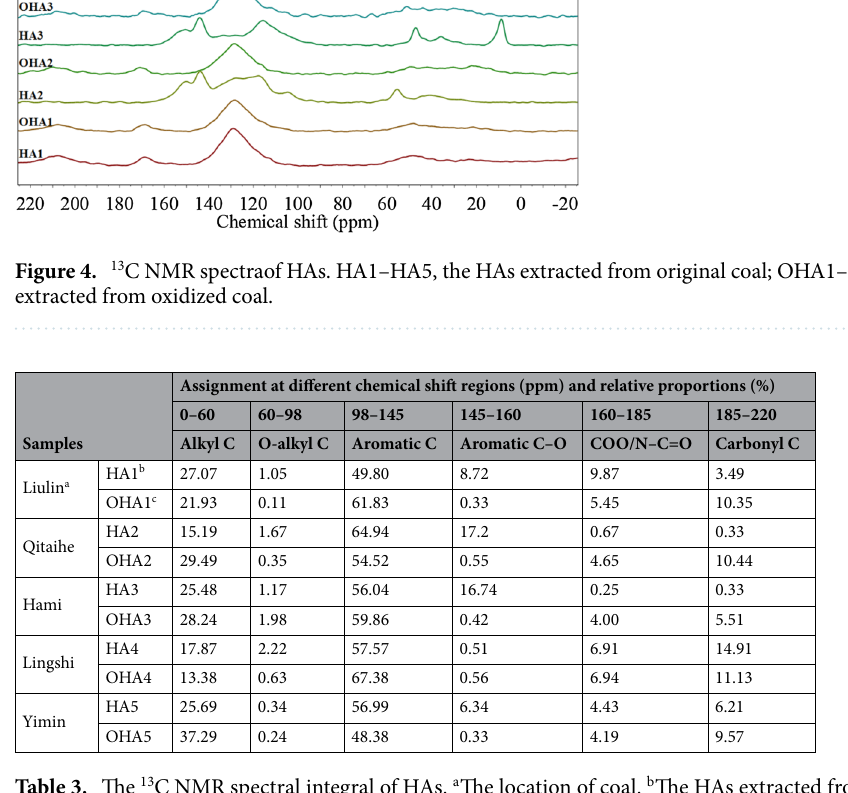
Table 3. The 13 C NMR spectral integral of HAs. a The location of coal. b The HAs extracted from original coal. c The HAs extracted from oxidized coal.